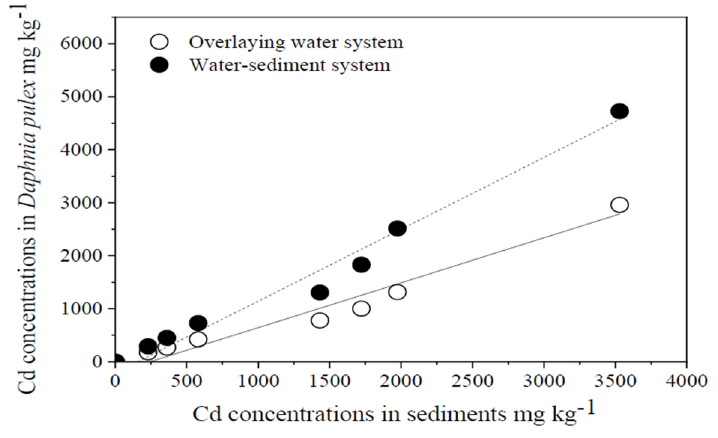
Figure 4. Cadmium concentrations in Daphnia pulex under different Cd pollution levels in sediments.